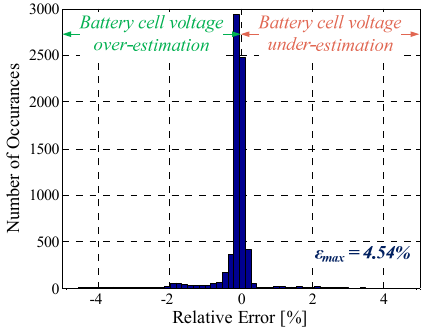
Figure 27. Distribution of the relative error obtained during the field-measured profile verification case.